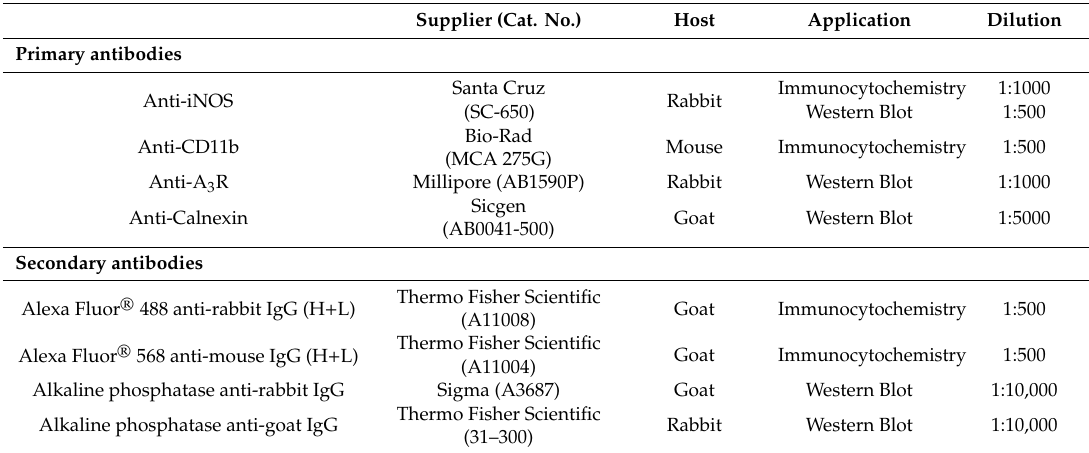
Table 1. List of primary and secondary antibodies used in the